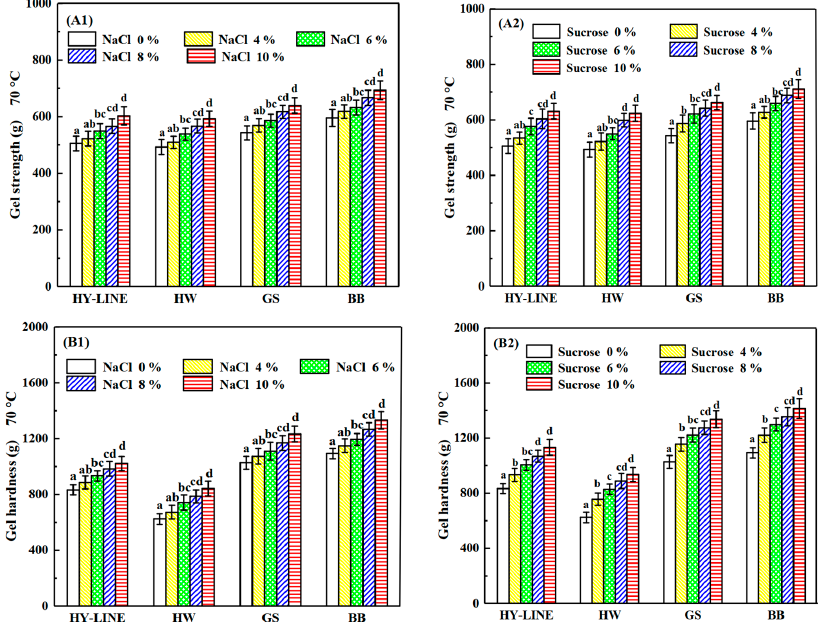
Figure 4. Gel strength and gel hardness of four varieties of EWP after heat treatment. ( A1 ) Gel strength of four varieties with different NaCl concentrations after heat treatment. ( A2 ) Gel strength of four varieties with different sucrose concentrations after heat treatment. ( B1 ) Gel hardness of four varieties with different NaCl concentrations after heat treatment. ( B2 ) Gel hardness of four varieties with different sucrose concentrations after heat treatment. Three replicate samples were measured for each treatment.